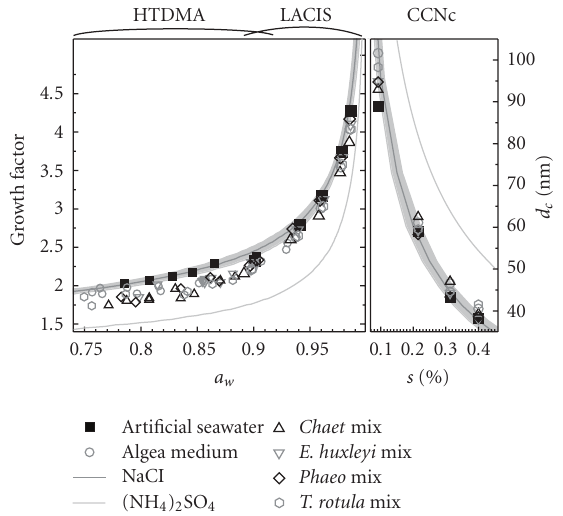
Figure 3: Left panel: Measured hygroscopic growth factors from the H-TDMA (smaller symbols) and LACIS (larger symbols). Right panel: Measured d c from the CCNc. Additional curves in both panels show the theoretical curves for sodium chloride and ammonium